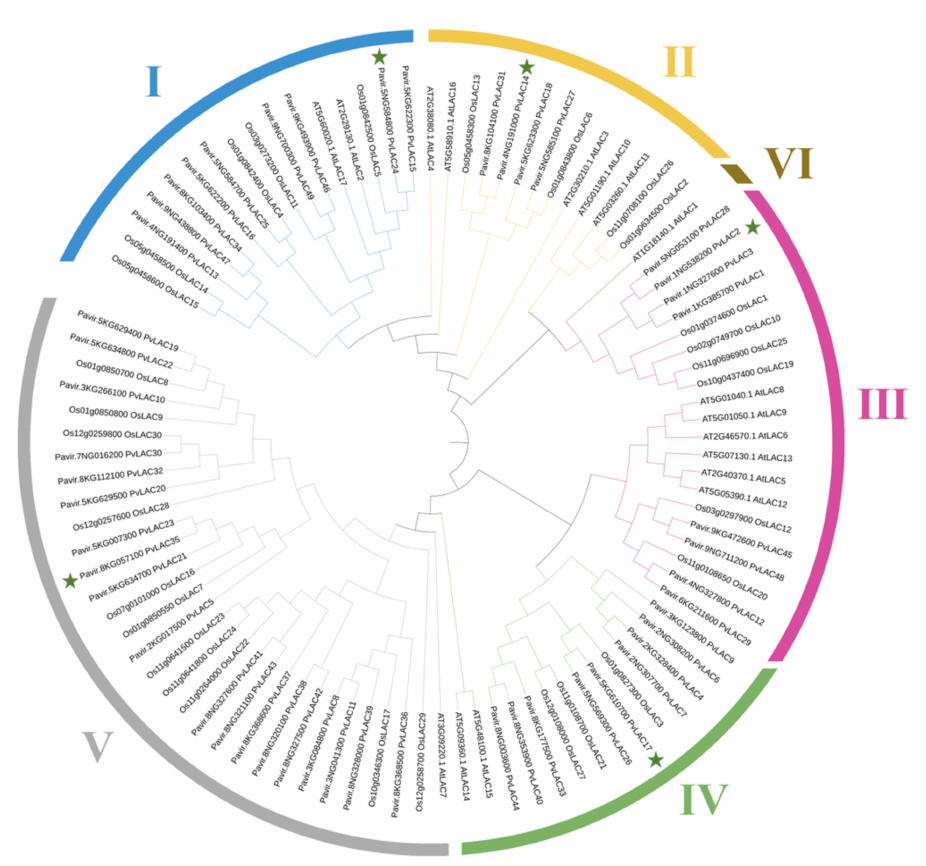
Figure 2. Phylogenetic analysis of PvLACs, OsLACs, and AtLACs. In total, 49 switchgrass, 29 rice, and 17 Arabidopsis laccase proteins were aligned using the ClustalW program, and the phylogenetic tree was constructed with MEGA 7.0 software using the neighbor-joining method with 1000 bootstrap replicates. The asterisks represent the five switchgrass genes selected from each subclade in this